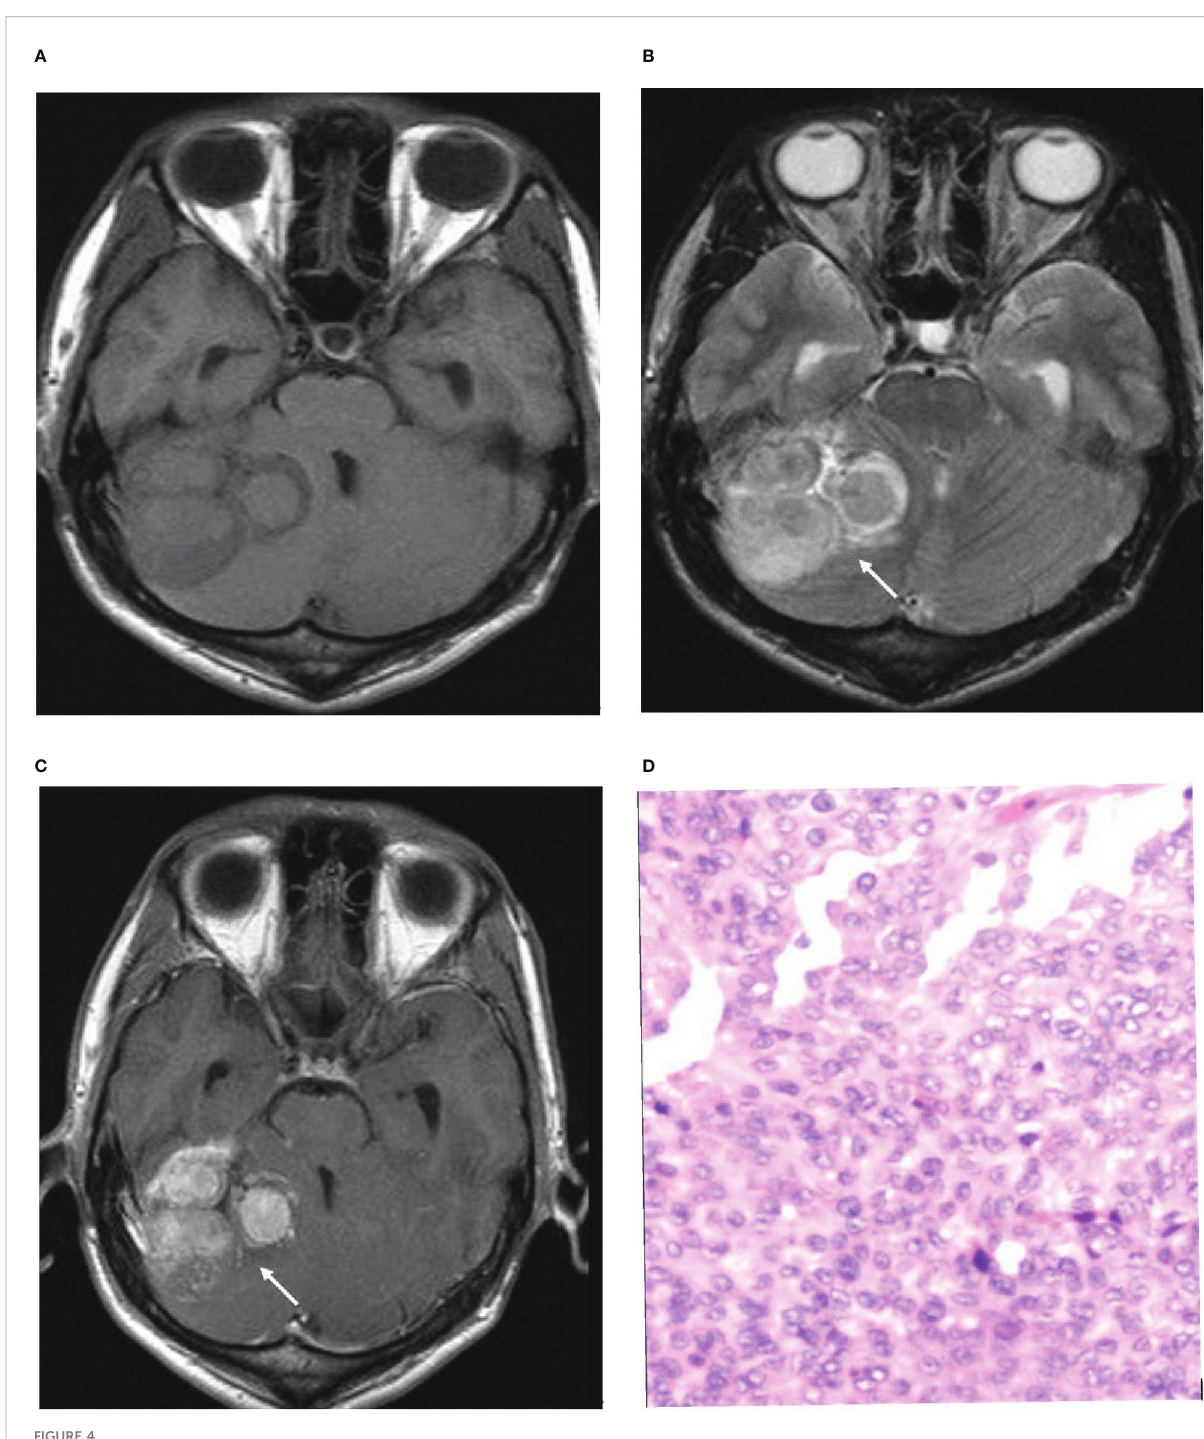
FIGURE 4 Illustrative example of the analyzed MRI variables. (A) Axial T1-weighted image. (B) Axial T2-weighted image. (C) Axial T1-weighted postcontrast image. (D) Pathological section. (B, C) Arrows show an unclear tumor-brain interface. (D) . Pathological examination con fi rmed brain